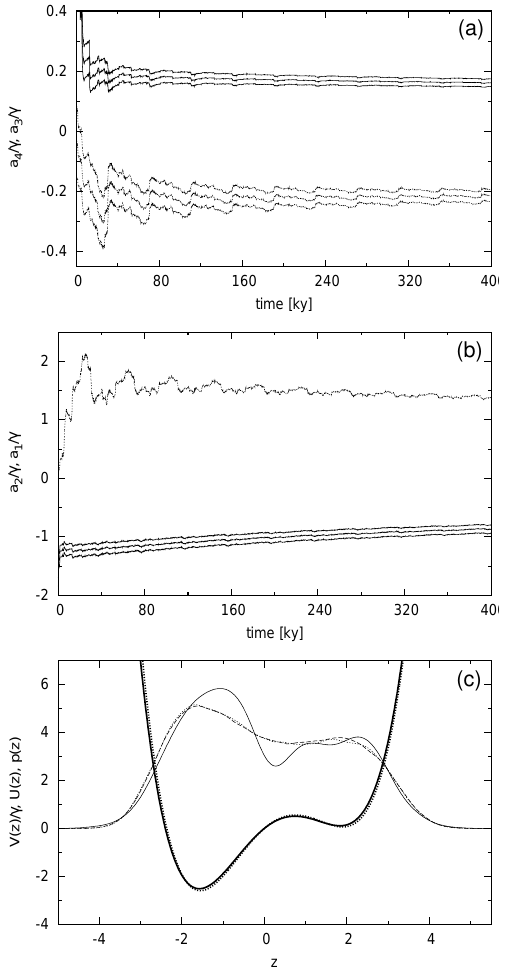
Fig. 8. (a) Record of δ 18 O from the NGRIP ice core for the last glacial period with the mean value removed. (b) Sample trajec- tory of the oscillator model. (c) Sample trajectory of the one- dimensional potential model.